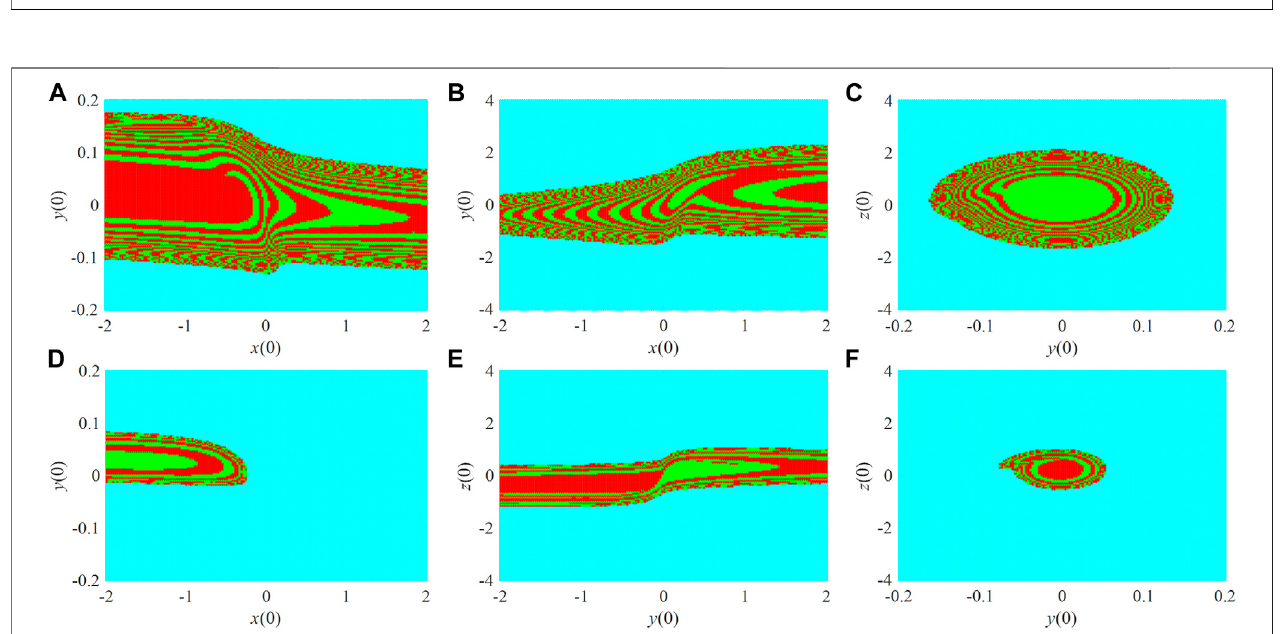
FIGURE 1 | Dynamics of the modi fi ed Chua ’ s system with the variation of the parameter α . (A) Bifurcation diagram; (B) Lyapunov exponents (LEs).